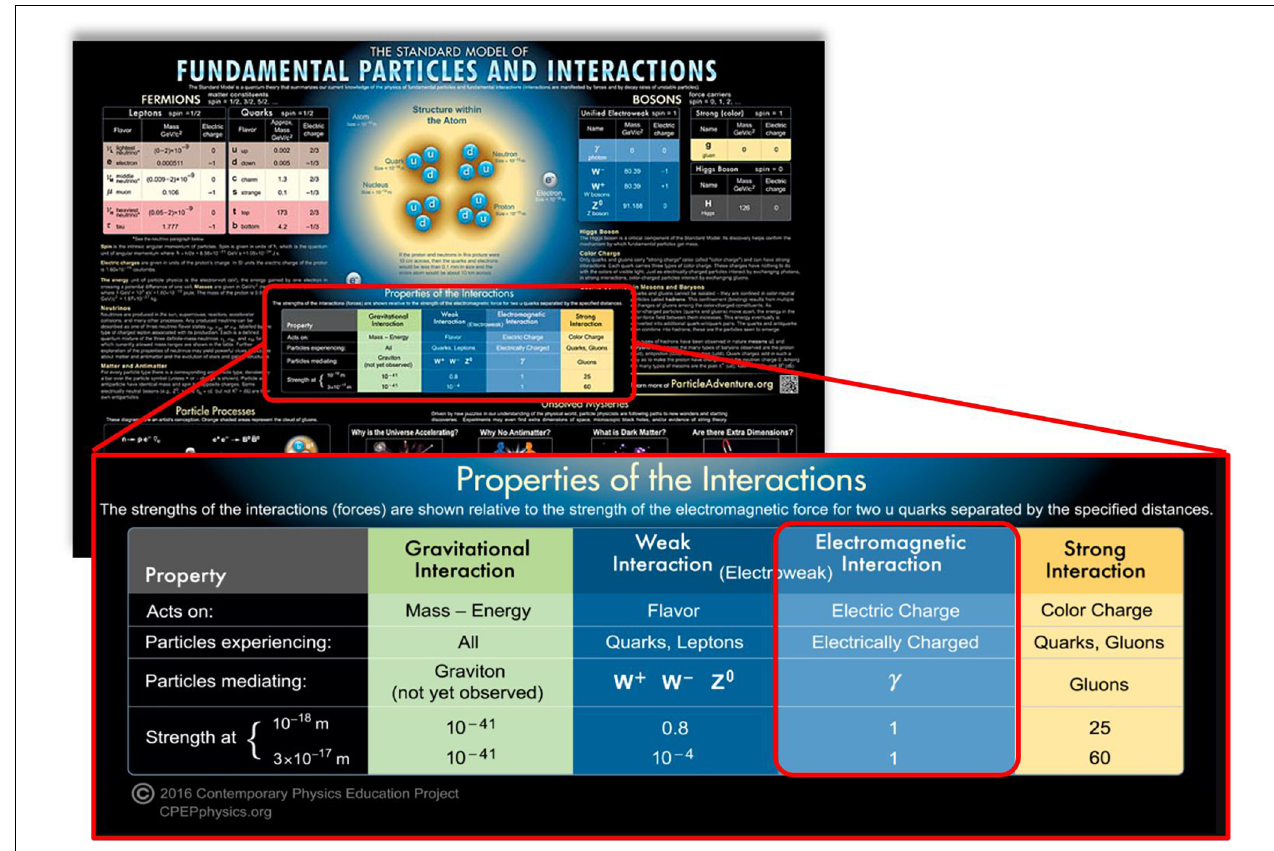
FIGURE 1 | A popular representation of the standard model of particle physics in which we find the four fundamental forces, within which is the electromagnetic force. For further information, a useful starting point can be found in Aitchison and Hey (1984), Halzen et al. (1985), Cottingham and Greenwood (2007), and Griffiths (2020). Credit: the model can be purchased in many forms from the non-profit “Contemporary Education Physics Project”